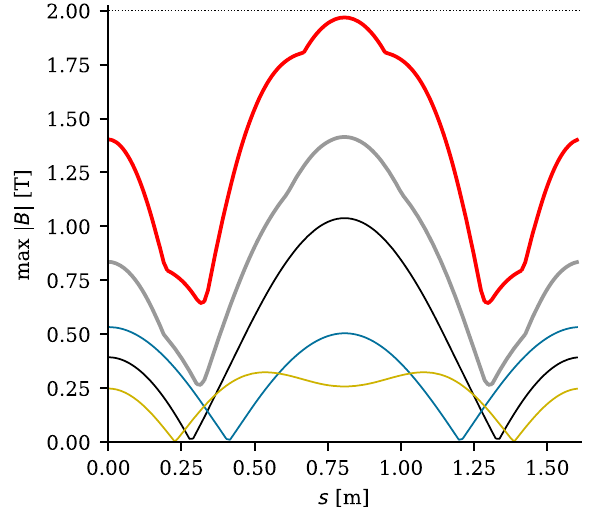
FIG. 14. Absolute maxima of dipole (black), quadrupole (blue) and sextupole (yellow) pole-tip fields, actual pole-tip field B pt r (gray), and weighted pole-tip field B w r (red) along s for the SLS 2.0 example (cf. Fig. 15).